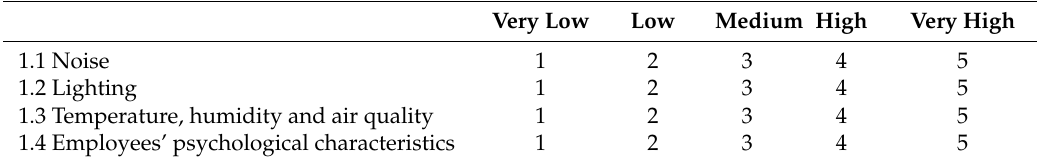
Table 4. Section of the MCQ related to the frequency of application of macroergonomic